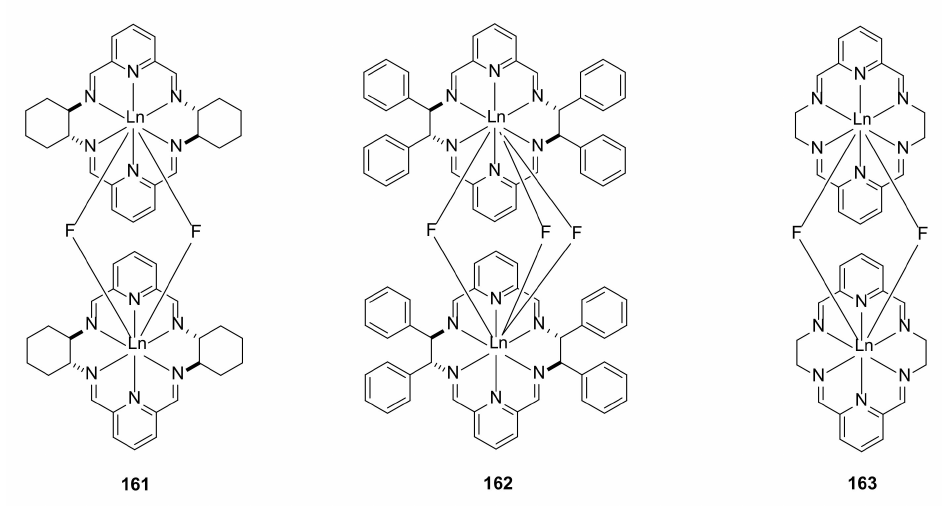
Figure 33. Dinuclear lanthanide (III) complexes of macrocyclic tetraimines 161 – 163 . The structure indicated by X-ray single-crystal analysis showed that two metal ions bounded by macrocycles were linked by two ( 161 and 163 ) or three ( 162 ) fluoride ions, depending on the type of the macrocycle of the same size. The differences in macrocyclic complexes’ dimmer formations were explained by the more open axial coordination spheres of the complexes of hexaaza macrocycles compared to cyclen-based tetraaza macrocycles. In the case of the dimmer complexes with two different macrocyclic ligands,